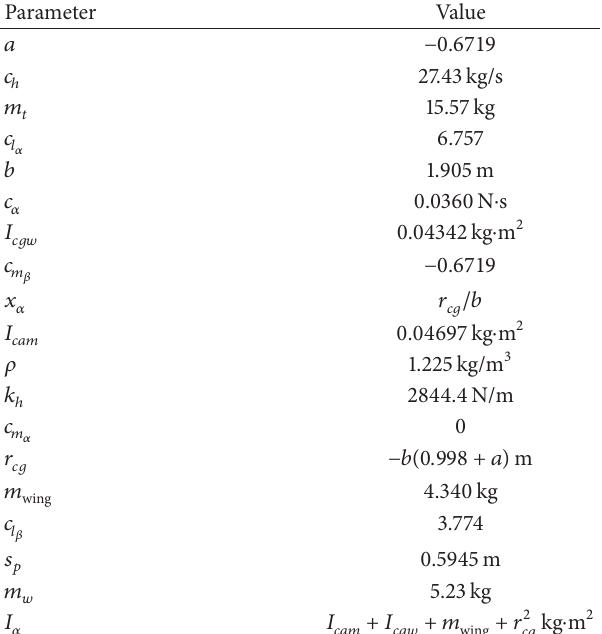
Figure 7: ILC control for graded gust, 𝑤 0 = 0.07 , 𝑈 = 16 m/s: (a) plunge displacement ℎ (m); (b) pitch angle 𝛼 (rad); (c) control input 𝛽 (rad).